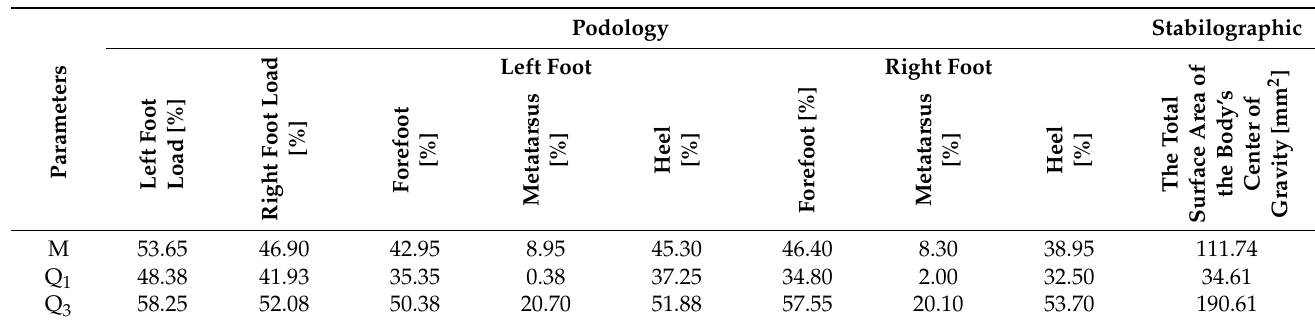
Table 2. Fundamental statistics of measurement values of podiatric and stabilographic examination parameters.